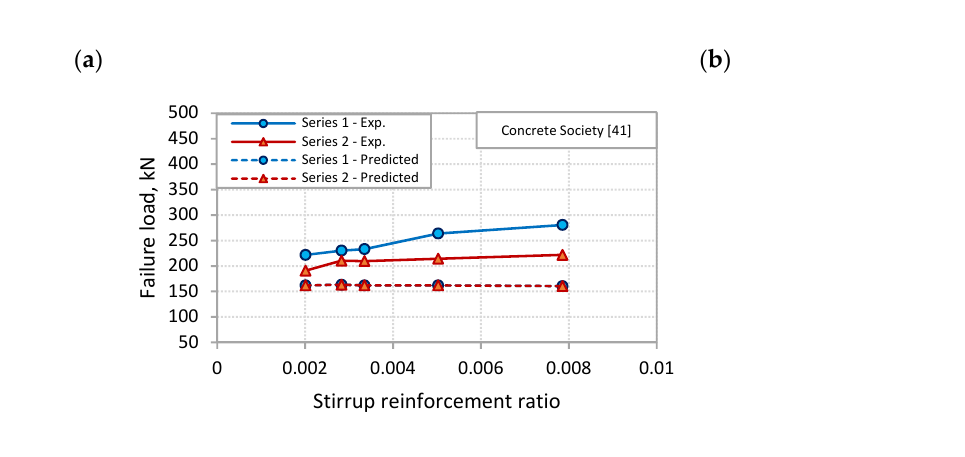
Figure 14. Comparisons of experimental versus predicted values for fracture energy-based code models: ( a ) fib Bulletin 90 [38]; ( b ) CNR-DT 200 R1 [51]; ( c ) Concrete Society [41].